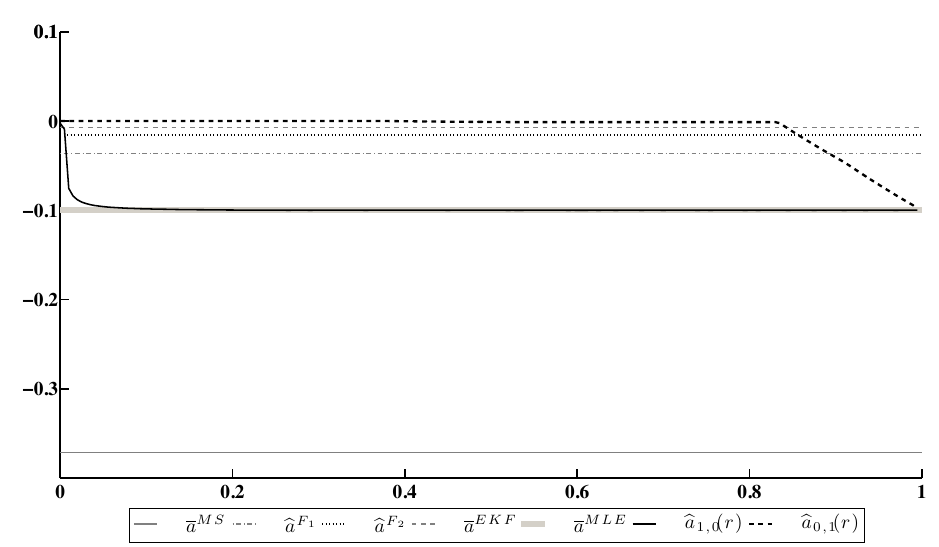
Figure 1. Estimation of the drift coefficient a .